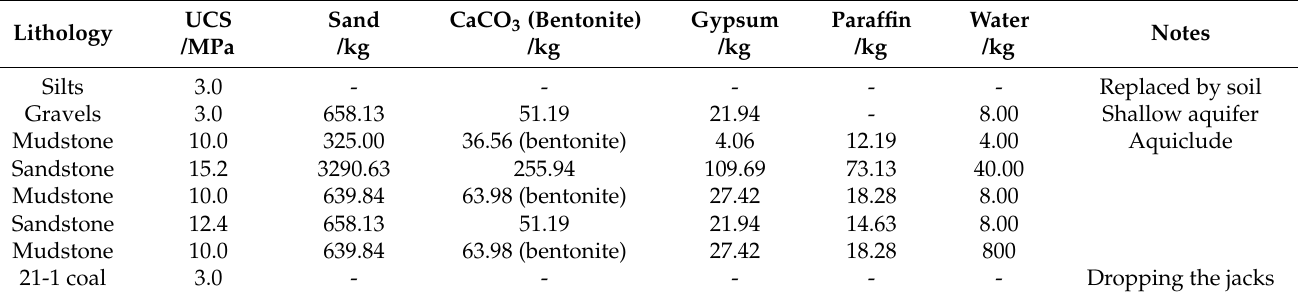
Table 1. Type and quality of materials used in physical simulation.